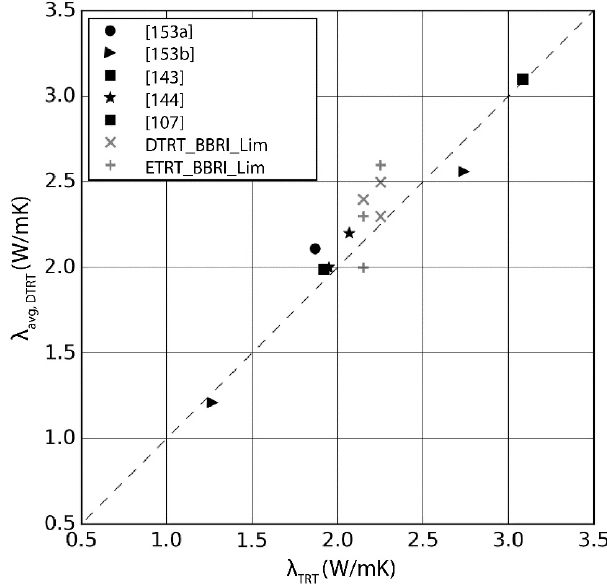
Figure 17. Average ground thermal conductivity by distributed thermal response tests (DTRTs), enhanced thermal response tests (ETRTs), and conventional TRT values as reported in References [107,143,144,148]. Table 1. Comparison of the classical and enhanced thermal response tests on two nearby boreholes in Limelette